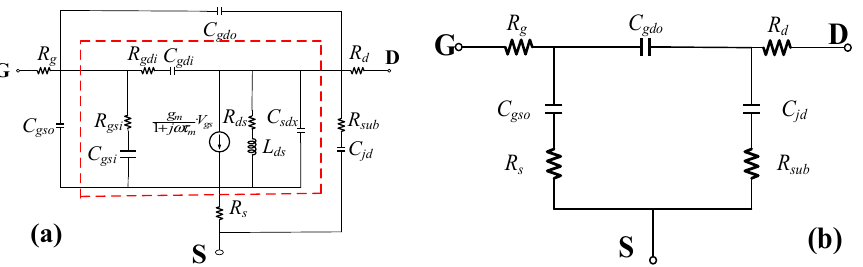
Figure 3. The equivalent circuit of intrinsic GAAFET under ( a ) ON-state, where the elements within the redline are bias-dependent, and ( b ) OFF-state, where the elements are bias-independent.